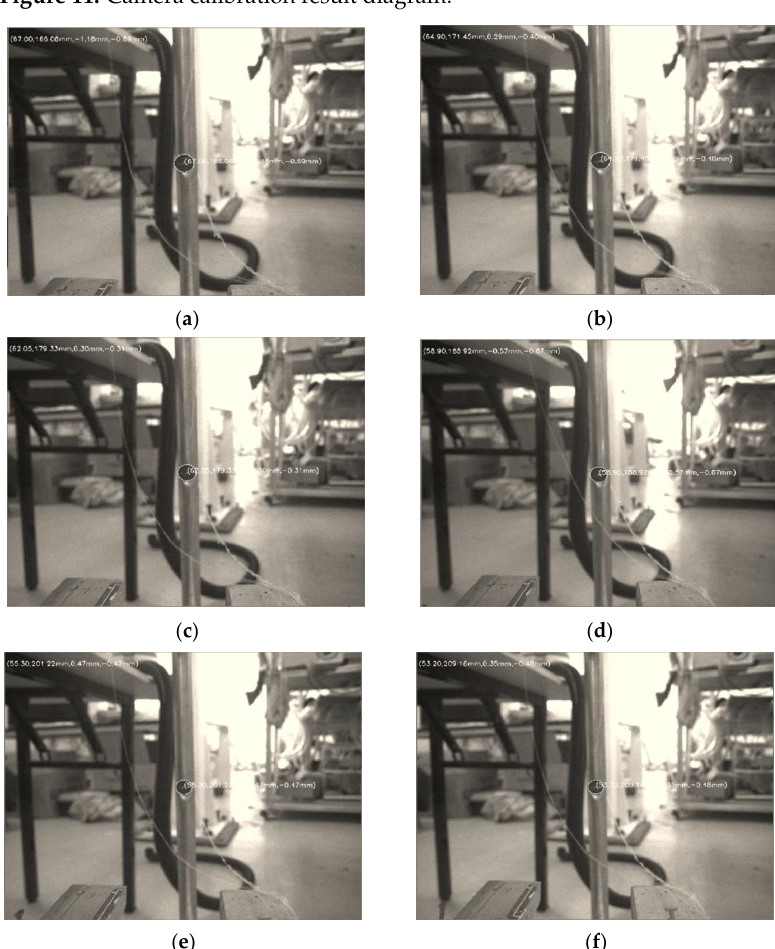
Figure 11. Camera calibration result diagram.